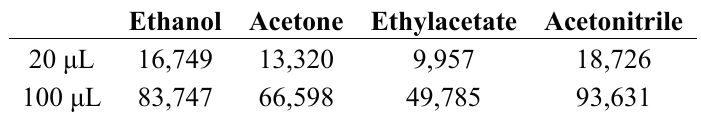
Table 2. Lists the concentration (ppm) of four chemicals at two different quantities.